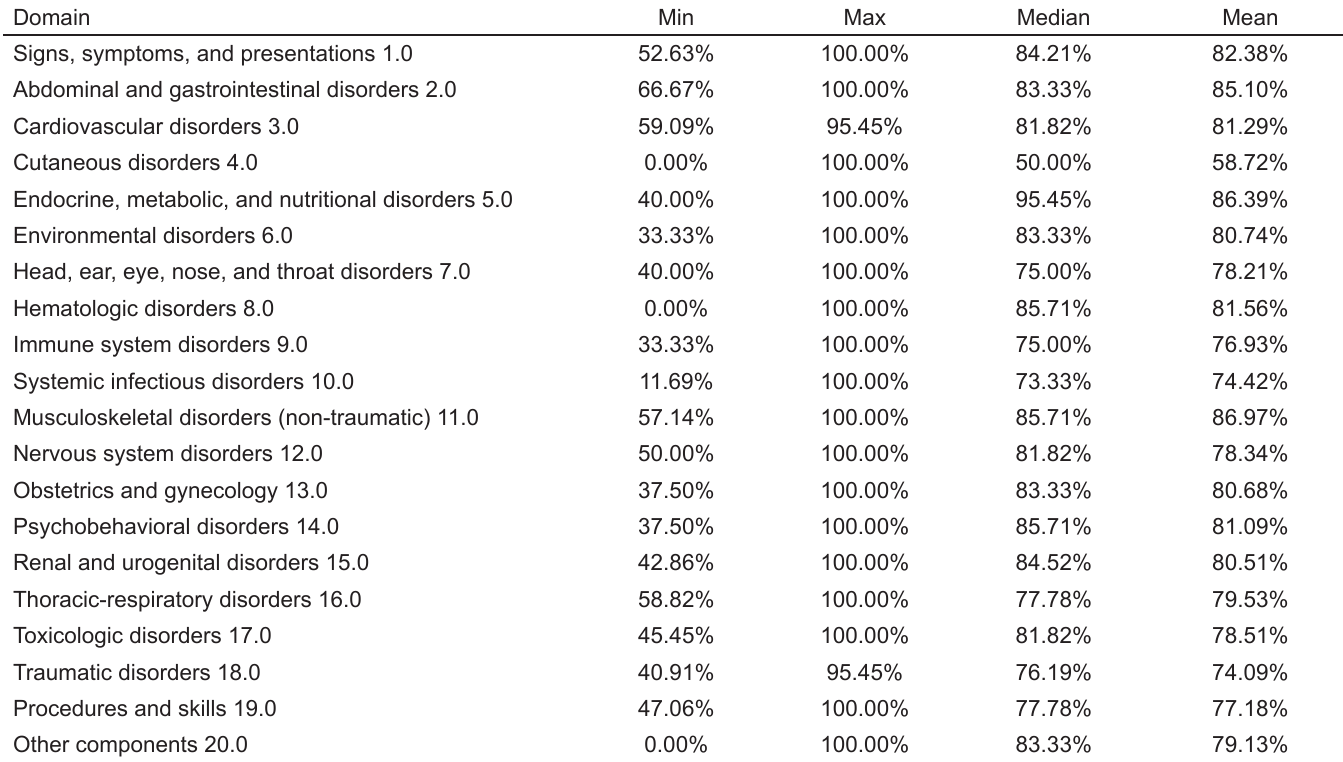
Table 1. Resident performance on the Emergency Medicine In-Training Examination.